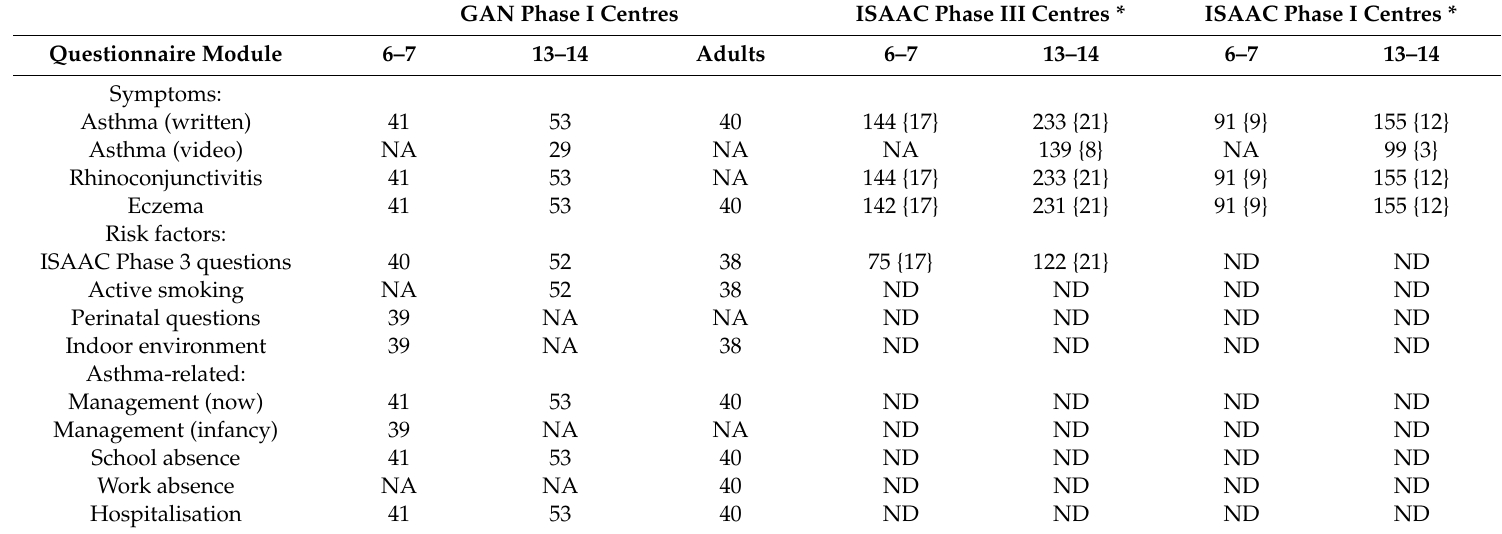
Table 1. Number of study centres contributing data for each GAN Phase I module and age-group, with corresponding data for International Study of Asthma and Allergies in Childhood (ISAAC) Phases I and